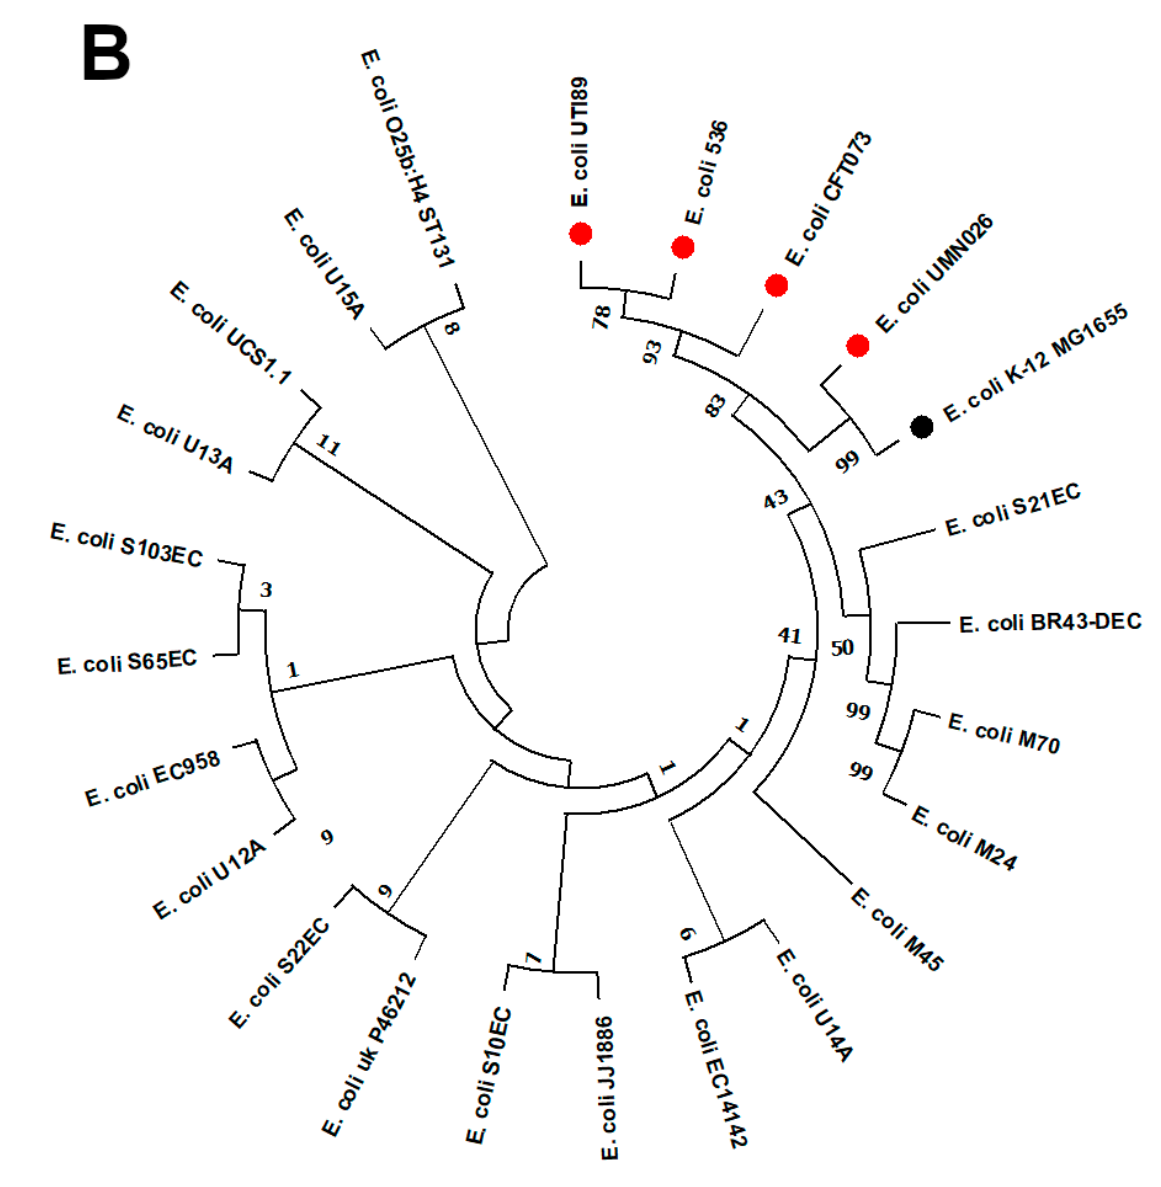
Figure 3. ( A ) Circular genome comparison of EGY_EC14142 chromosome with other chromosomes of UPEC strains. Each of the genome sequence assemblies of UPEC strains was aligned against EGY_EC14142 using the Basic Local Alignment Search Tool nucleotide tool (BLASTn) and visualized using the BLAST Ring Image Generator (BRIG) tool. The outermost ring (red) corresponds to EGY_EC14142 chromosome belonging to EC14142 strain, with its size being displayed in the middle of the ring. Next, UTI89 (NC_007946) is shown (light green). The third ring corresponds to UMNO26 (NC_011751) (pink), then, 536 (NC_008253) (purple) and CFT073 (NC_004431) (dark green) are shown. Genomic regions covered by BLASTn are represented by a solid color in concentric rings (with varying color degrees depending on percentage identity), whereas white gaps indicate genomic regions not covered by BLASTn. ( B ) Phylogenetic tree of EC14142 relative to 22 UPEC strains. The phylogenetic tree was generated using MEGA software (v11.0.9) with the maximum likelihood approach according to the aligned sequences by Clustal Omega. E. coli K-12 MG1655 (NC_000913.3) was set as a reference, and it is displayed in black. Referral strains, 536 (NC_008253), CFT073 (NC_004431), UTI89 (NC_007946), and UMNO26 (NC_011751) are indicated by red bullets. A bootstrap replication value of 100 was